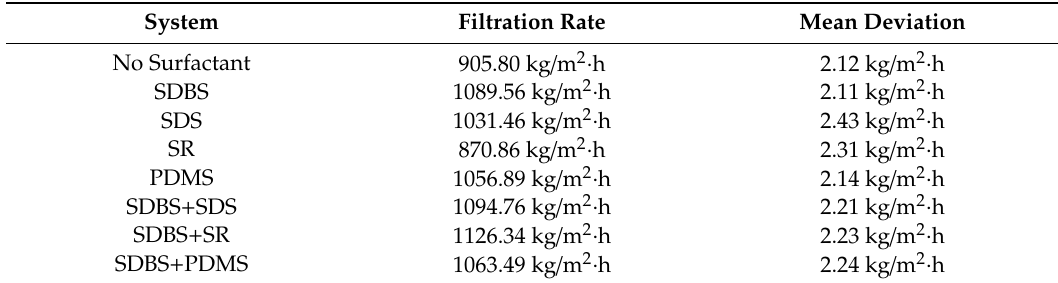
Table 6. Of the species of surfactants on the filtration rate of phosphogypsum.